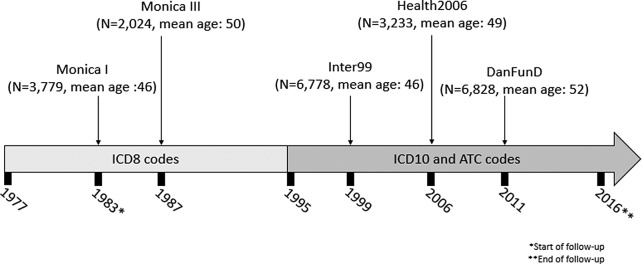
Timeline for International Classification of Disease version 8 and 10 (ICD8 and ICD10) codes and Anatomic Therapeutical Chemical (ATC) codes to obtain information on cardiovascular disease and depression for the specific sub-cohorts’ baseline.